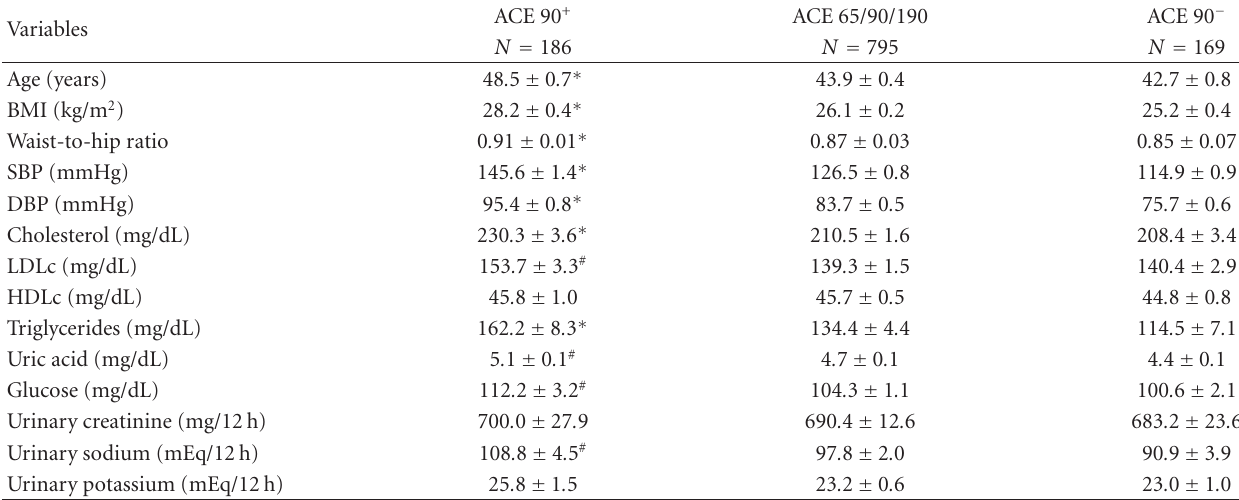
Table 2: Anthropometric, clinical, and laboratory variables of the study population according to ACE isoforms. Variables